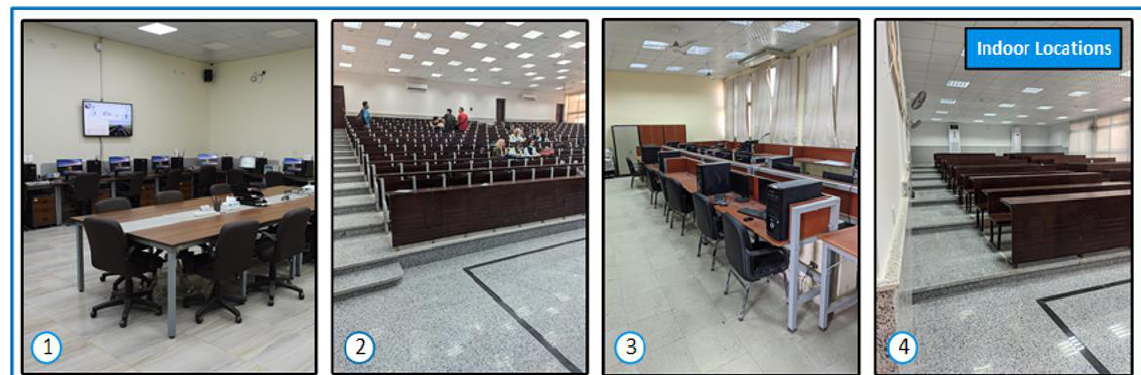
Figure 10. Images of indoor locations.